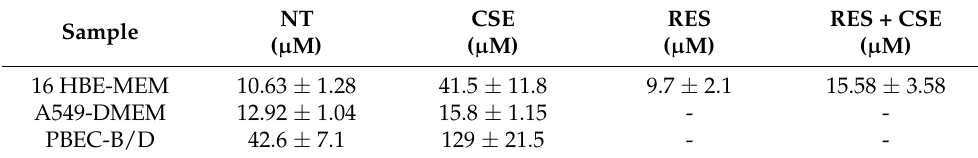
Table 4. Real samples analysis tested using AuNPs-rGO-based sensors with LSV.